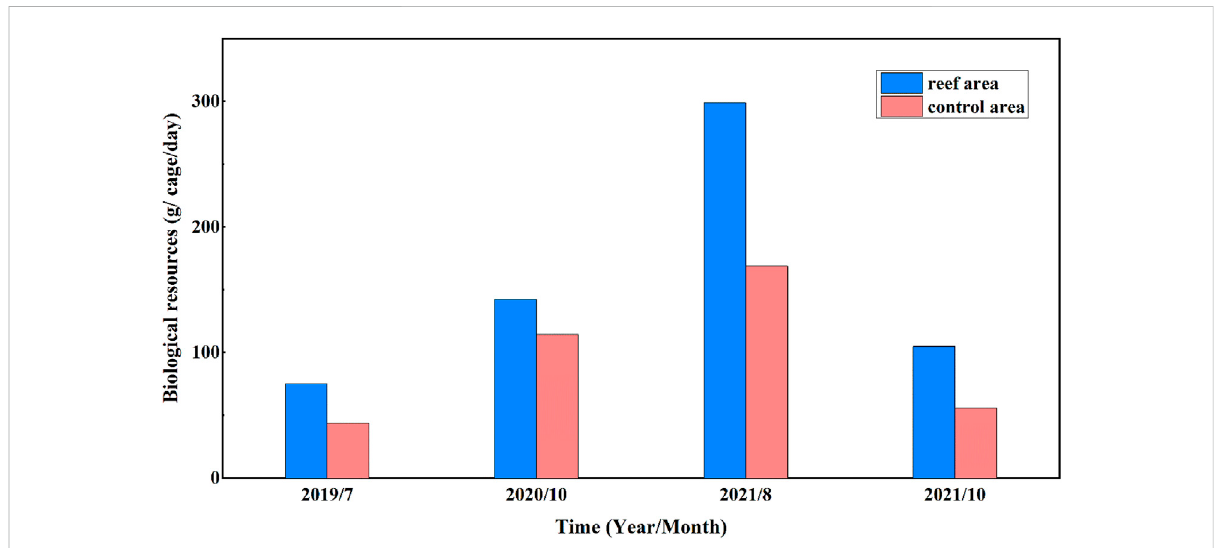
FIGURE 9 Comparison of biological resources in the arti fi cial reef working site and contrasting control area.